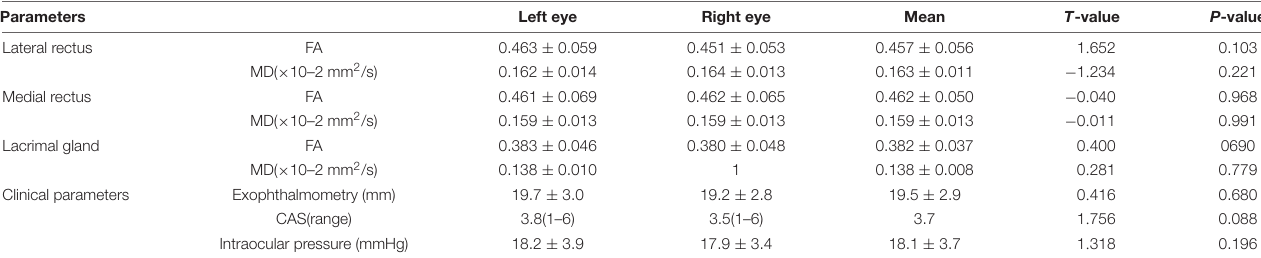
TABLE 2 | Comparison of left and right orbital soft tissue DTI parameters and clinical parameters.